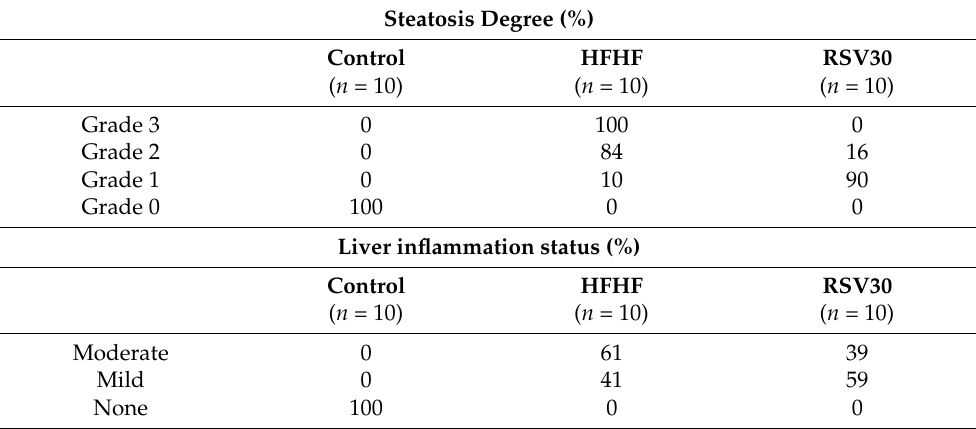
Table 1. Liver steatosis degree and inflammation in rats fed a control diet (C), a high-fat high-fructose diet (HFHF) or a high-fat-high-fructose diet supplemented with 30 mg/kg/d resveratrol (RSV30). Values are presented as percentage.